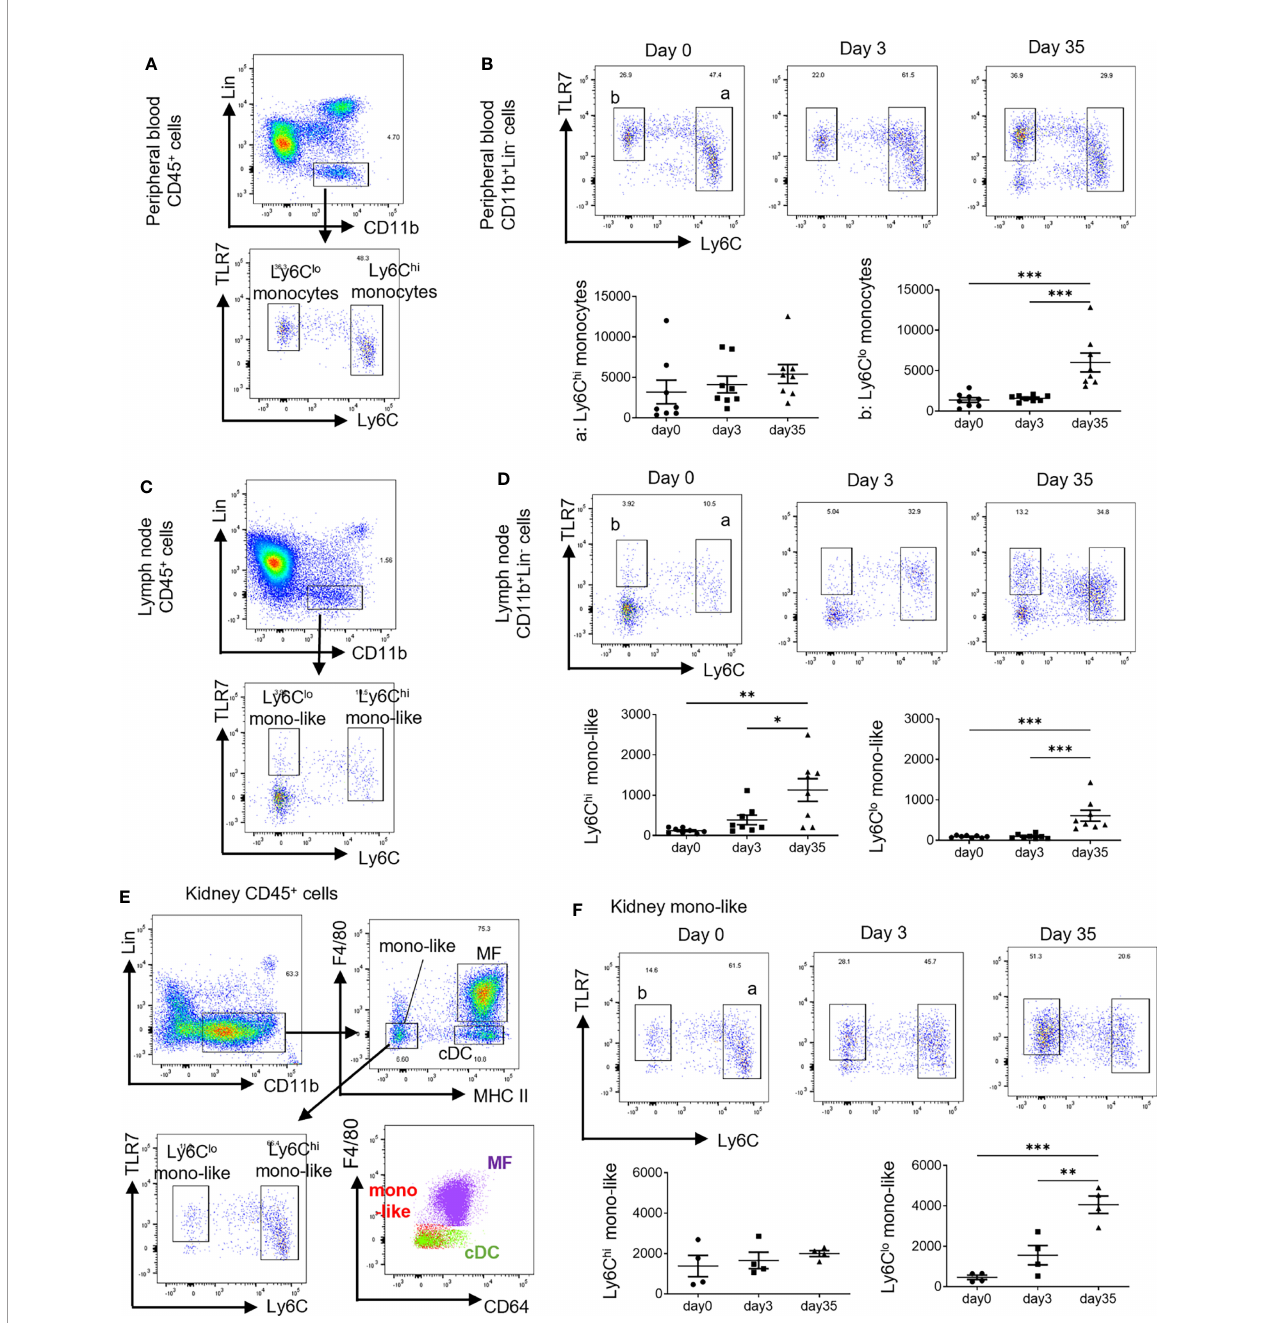
FIGURE 1 | Different spatial and temporal increases in monocyte-like cells by treatment with IMQ. In the short-term analysis, C57BL/6 mice were treated with 40 mg of IMQ on days 0 and 2, then sacri fi ced on day 3. In the long-term analysis, mice were treated with 40 mg of IMQ three times a week for 35 days. (A) Monocytes were identi fi ed as CD11b + Lin - cells in the peripheral blood. Ly6C hi monocytes and Ly6C lo monocytes are shown relative to the expression of TLR7. (B) The change of peripheral Ly6C hi and Ly6C lo monocytes at 3 and 35 days after the application of IMQ. (C) Among CD11b + Lin - cells in the lymph nodes, Ly6C hi monocyte-like cells and Ly6C lo monocyte-like cells were identi fi ed based on the expressions of Ly6C and TLR7. (D) The change of cervical lymph node monocyte-like cells 3 and 35 days after the application of IMQ. (E) Kidney monocyte-like cells were identi fi ed as CD11b + Lin - F4/80 - MHCII lo cells. (F) Changes in kidney monocyte-like cells at 3 and 35 days after the application of IMQ. (B, D, F) show the combined data of two experiments. Numbers in the graph represent the number of cells per 100,000 CD45 + cells. Symbols represent individuals and horizontal lines indicate the mean and SEM. *P < 0.05, **P < 0.01, and ***P < 0.001 by one way ANOVA and post hoc Tukey ’ s multiple comparison test. IMQ, imiquimod; Lin, lineage marker (CD3, CD19, Ly6G, NK1.1); mono-like, monocyte-like cells; MF, macrophages; cDC, conventional dendritic